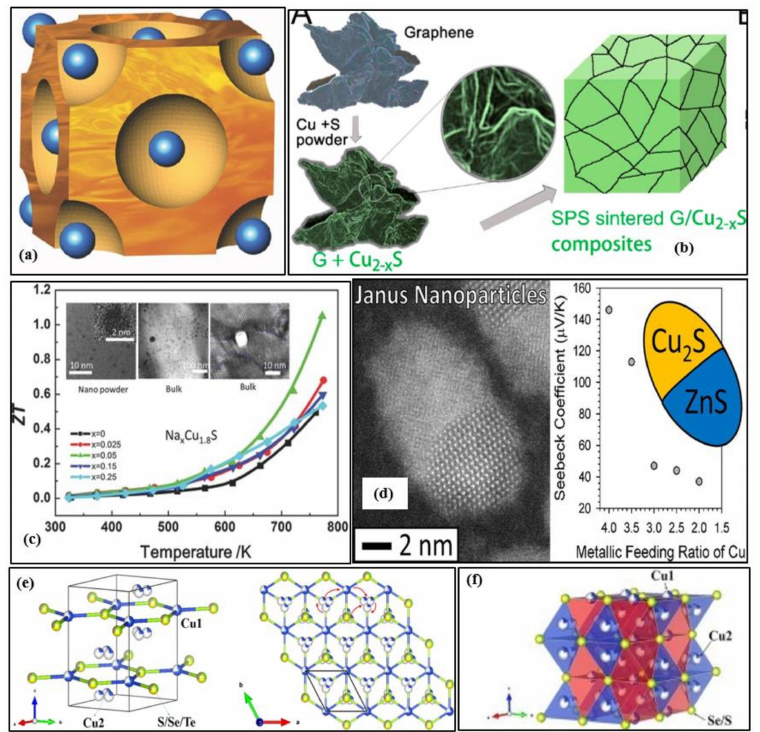
Figure 3. ( a ) The crystal structure of the cubic-chalcocite α phase of Cu 2 − x S (the sulfur atoms are represented by the blue spheres), Reproduced with permission from [39]. Copyright © 2014, Wiley Online Library, ( b ) Schematic representation of the spark plasma sintering process for fabricating graphene/Cu 2 − x S nanocomposites, Reproduced with permission from [22]. Copyright © 2018, Elsevier, ( c ) The temperature dependence of figure of merit ZT value for Cu 9 S 5 sample with differ- ent sodium contents. The inset shows nanostructure in the TEM image of Na 1 − x Cu 9 S 5 powders, Reproduced with permission from [31]. Copyright © 2016, Wiley Online Library, ( d ) Schematic Illustration of STEM-HAADF image of copper sulfide-zinc sulfide Janus nanoparticles at 2nm size and dependence of the Seebeck coefficient on the metallic feeding ratio of copper, Reproduced with permission from [35]. Copyright © 2016, ACS Publications. ( e ) Visualization of the crystal structure with a space group (P6 3 / mmc ) at 100 K of Cu 2 − y S 1/3 Se 1/3 Te 1/3 (Hexagonal structure), Reproduced with permission from [32]. Copyright © 2017, Elsevier., ( f ) Visualization of the crystal structure with a space group (P6 3 / mmc ) at 100 K of Cu 2 Se 0.5 S 0.5 , Reproduced with permission from [33].